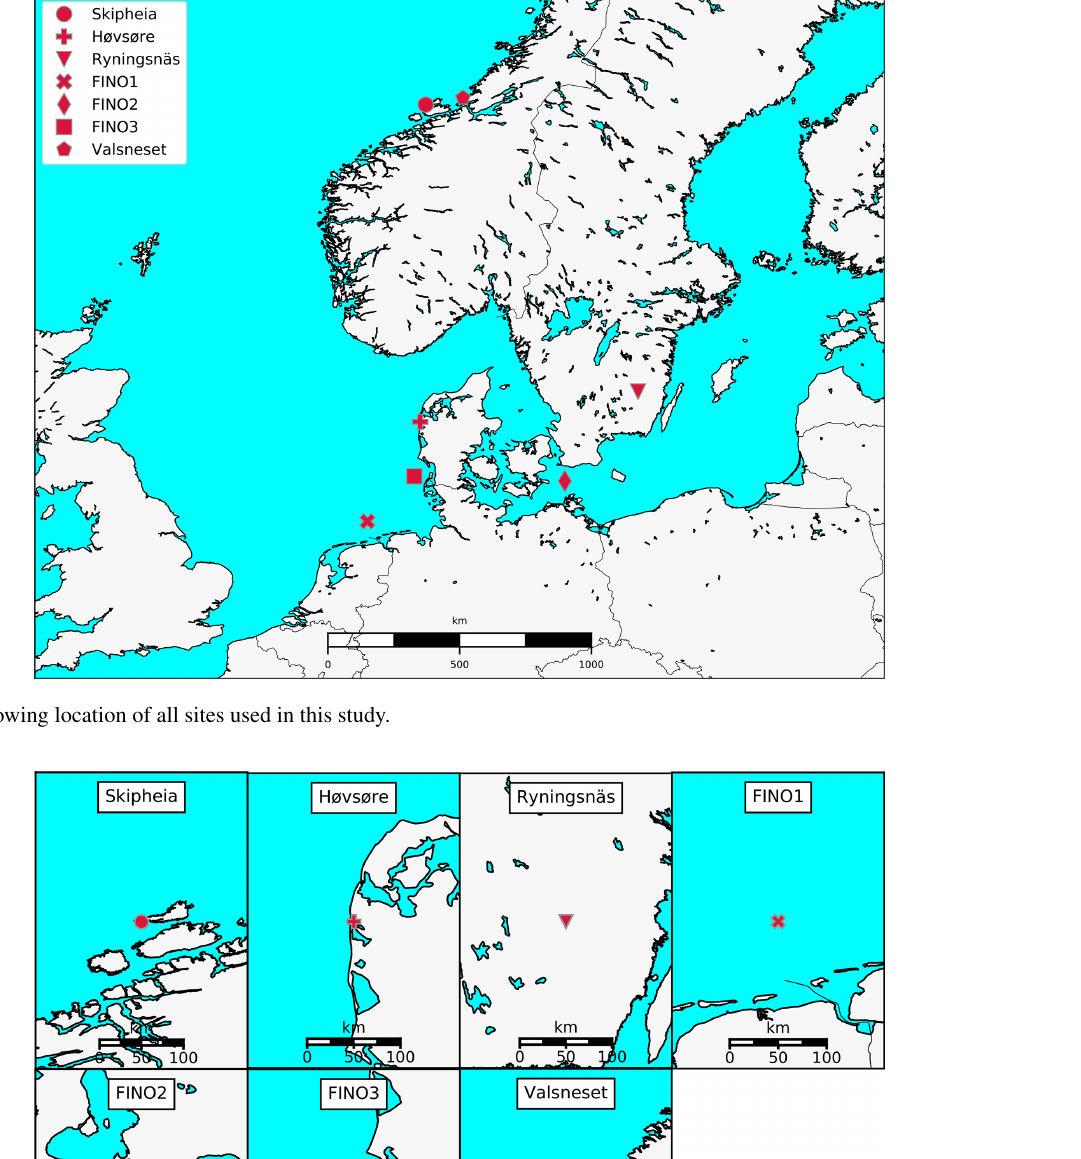
Figure 4. Close-up of each site location.